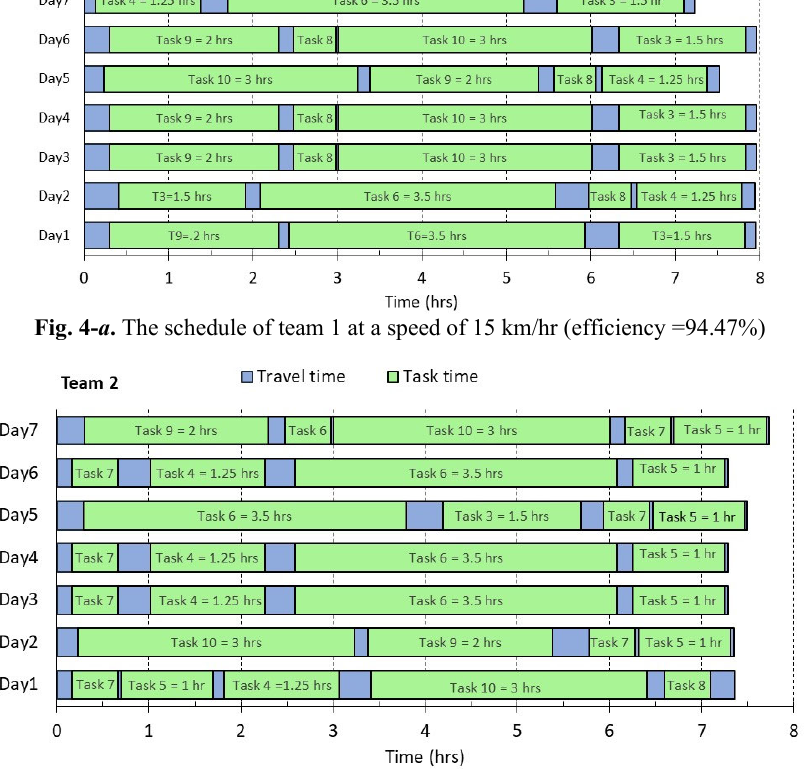
Fig. 4- b . The schedule of team 2 at a speed of 15 km/hr (efficiency =95.95%)